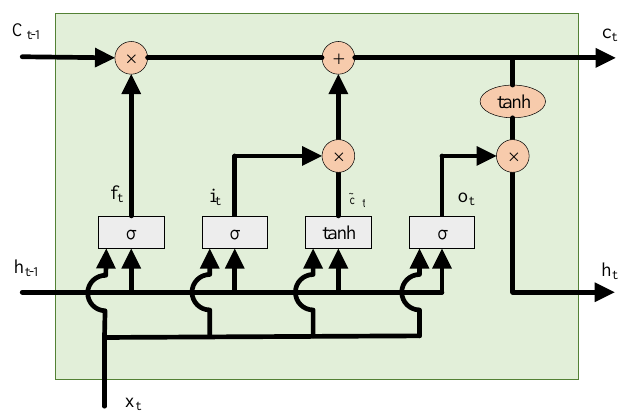
Figure 1. Structure of cell in LSTM. Adapted from Le